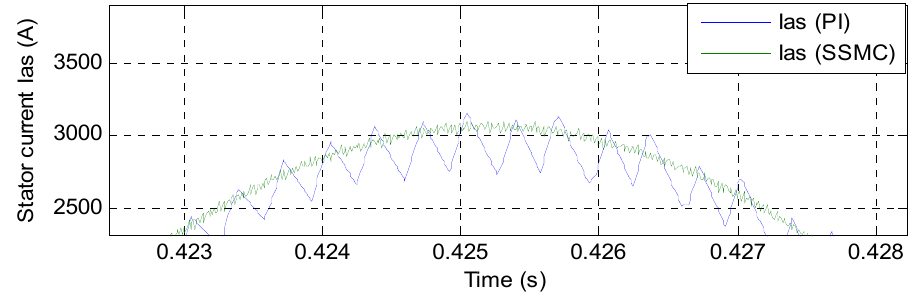
Figure 21. Zoom (Current).